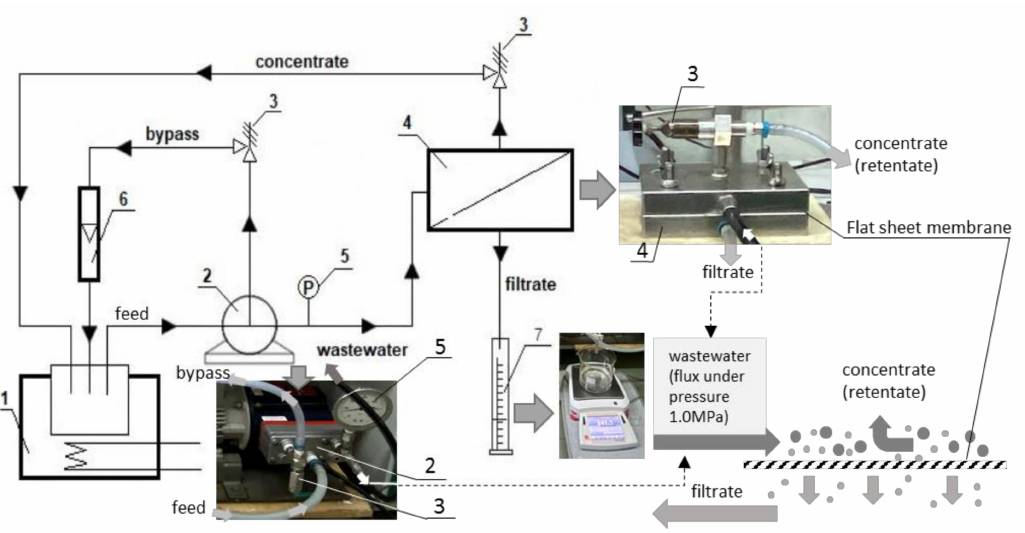
Figure 1. Schematic diagram of the nanofiltration system: 1—thermostat; 2—pump; 3—control valves; 4—pressure chamber with the membrane; 5—manometer; 6—rotameter; 7—measuring cylinder.